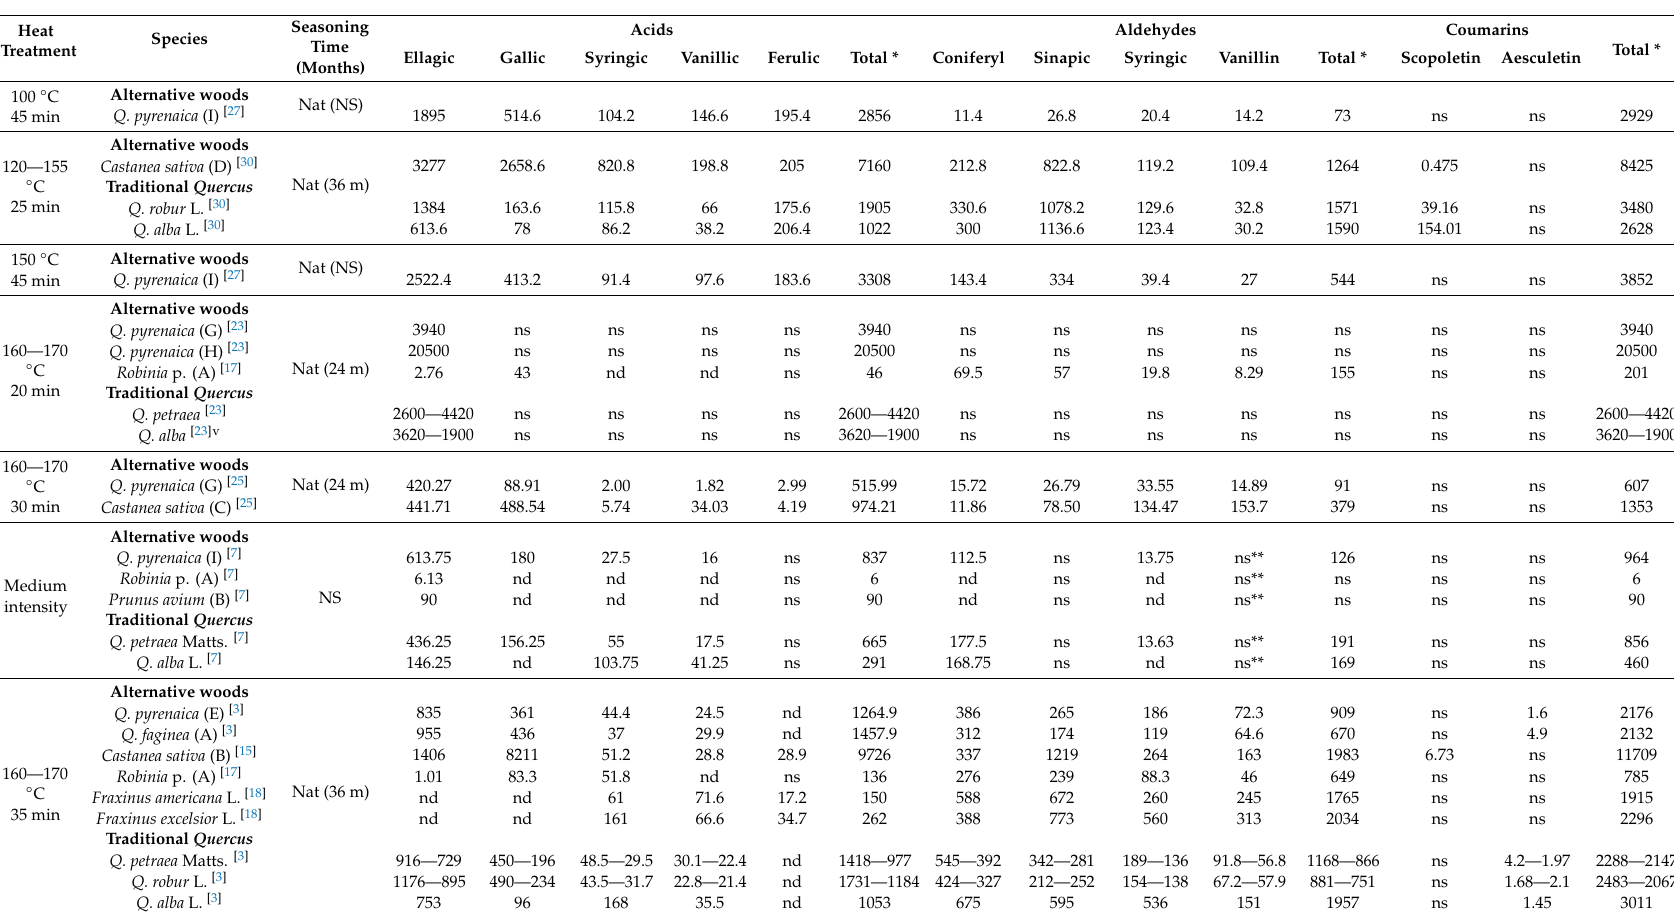
Table 7. Mean of the concentration expressed as µ g / g of the low molecular weight phenolic compounds found in woods of di ff erent botanical origin after toasting. Heat